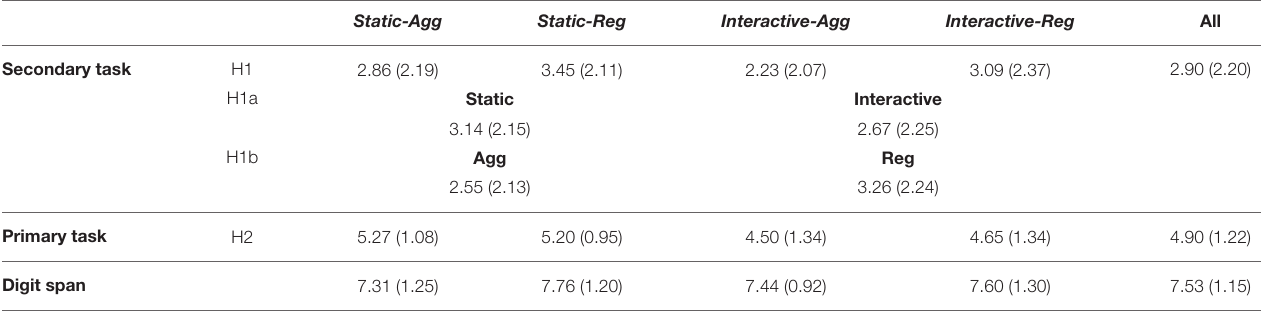
TABLE 2 | Experiment 1, Mean (StD) in secondary task of number of words remembered correctly in the serial recall task out of maximum 8, in primary task of plan questions answered correctly out of maximum 6, and of digit span. Static-Agg Static-Reg Interactive-Agg Interactive-Reg